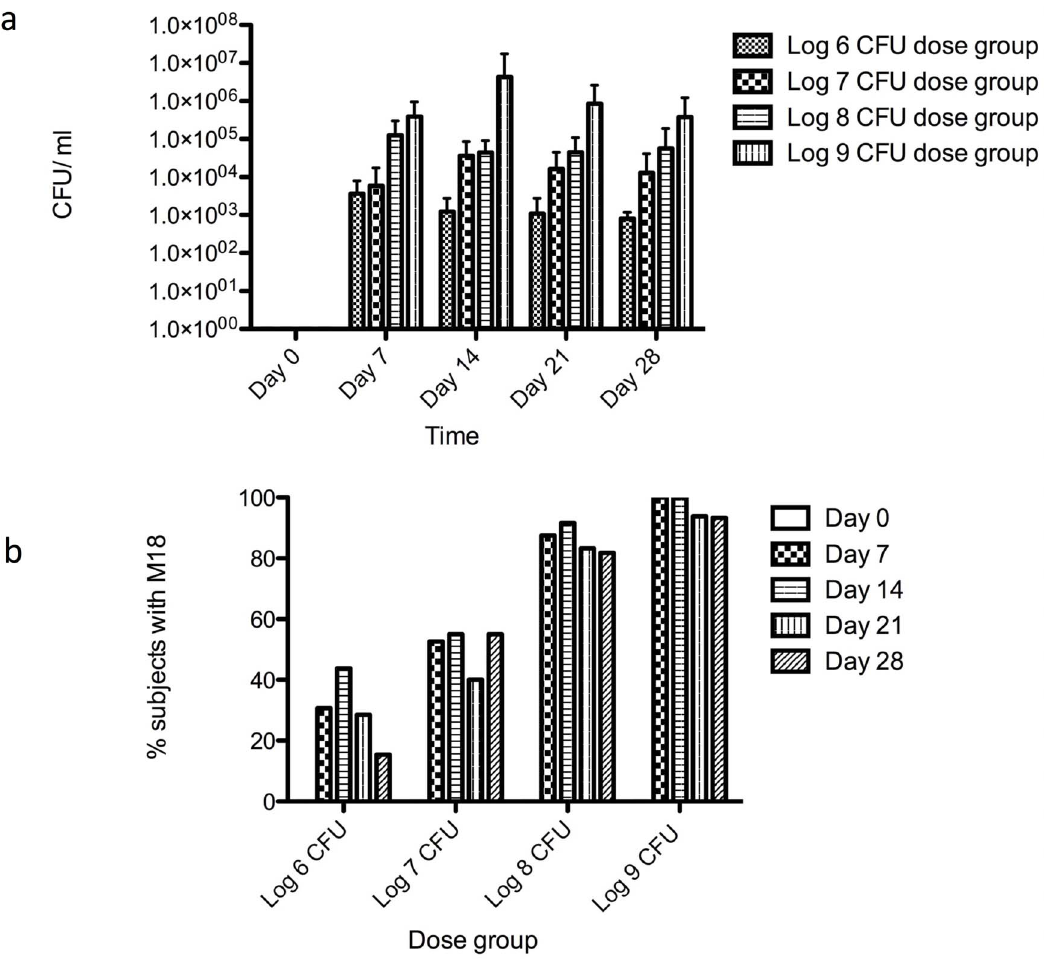
Figure 3. a. Mean number of S.salivarius M18 detected in saliva samples at different time points receiving different probiotic doses (error bars denote ± SD). b. Percentage of subjects with S. salivarius M18 detected in saliva samples.